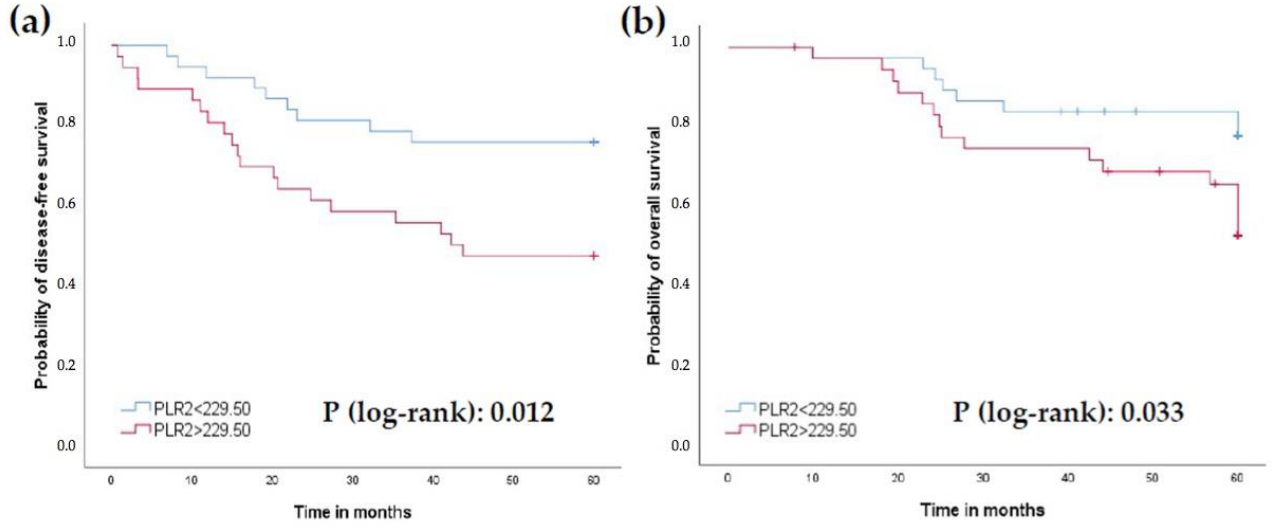
Figure 4. Prognostic role of LMR2 levels with a cut-off value of 1.26. ( a ) Progression-free survival (PFS). ( b ) Overall survival (OS).